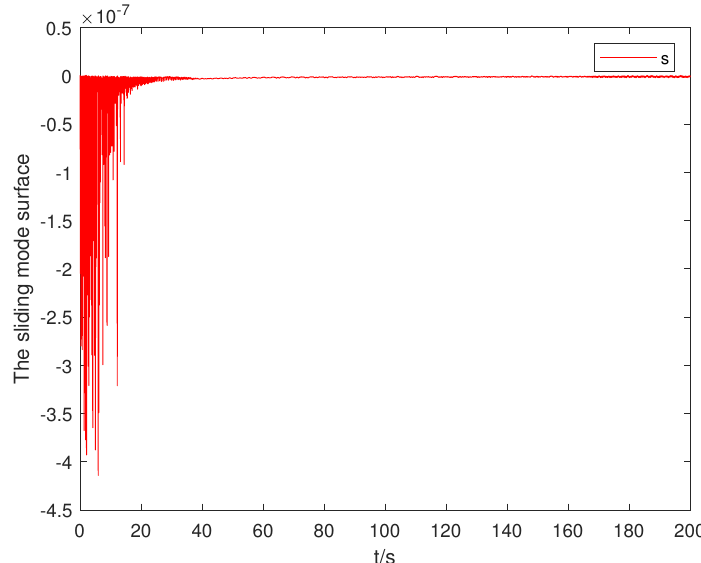
Figure 3. Moving track of the sliding-mode surface s ( t ) .